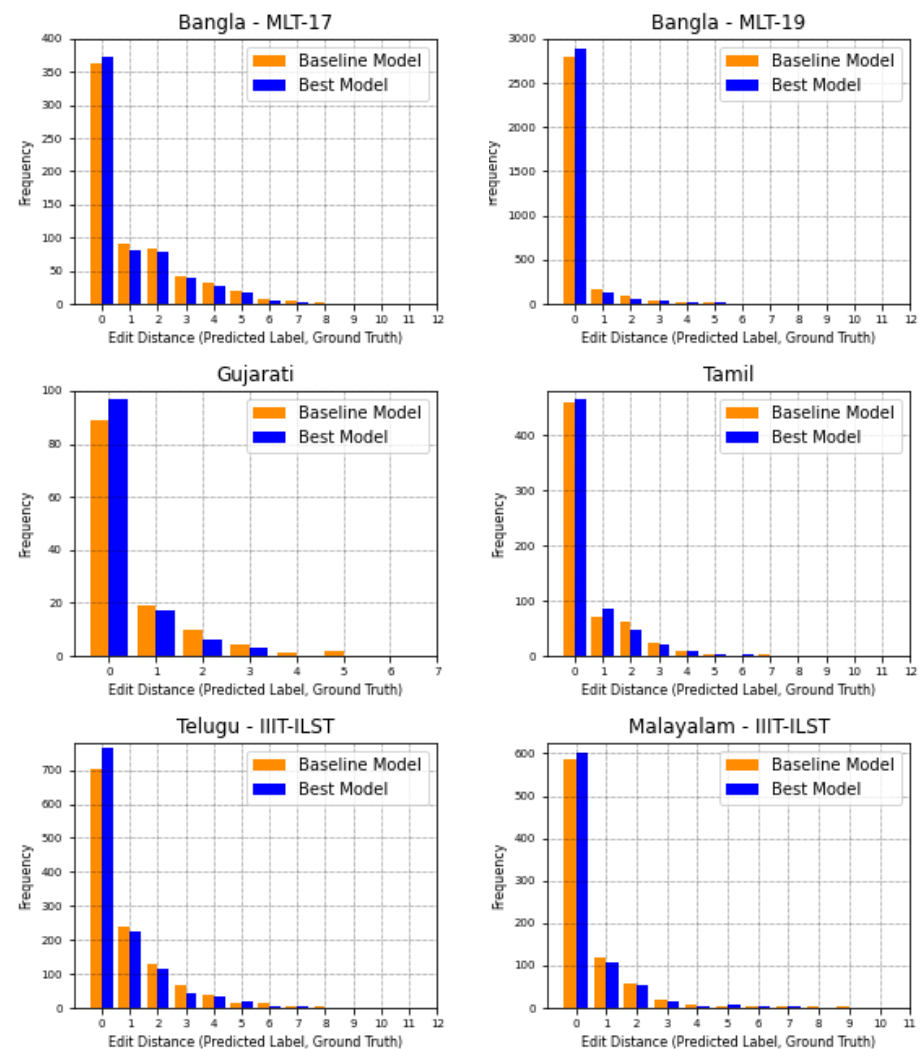
Figure 11. Histogram of correct words ( x = 0) and words with x errors ( x > 0) for Baseline 2 model as baseline model and the best model trained so far evaluated on real datasets for six languages (Hindi, Bangla, Gujarati (our dataset) , Tamil (our dataset), Telugu and Malayalam in row-wise